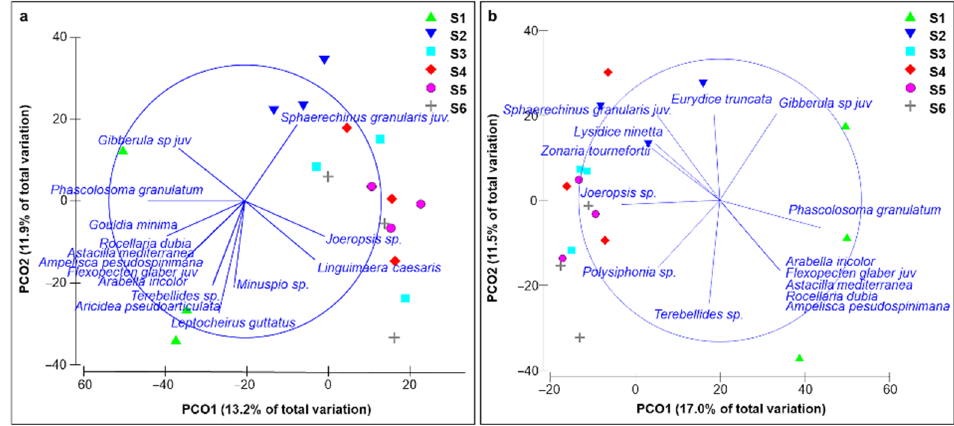
Figure 9. Principal Coordinates Analysis (PCO) ordination plot of the sampling sites related to macrofauna abundances among sampling sites ( a ) and related to macrofauna and macroflora presence among sampling sites ( b ). Correlation vector is based on Pearson ranking. Table 2. Number of species and individuals for each trophic